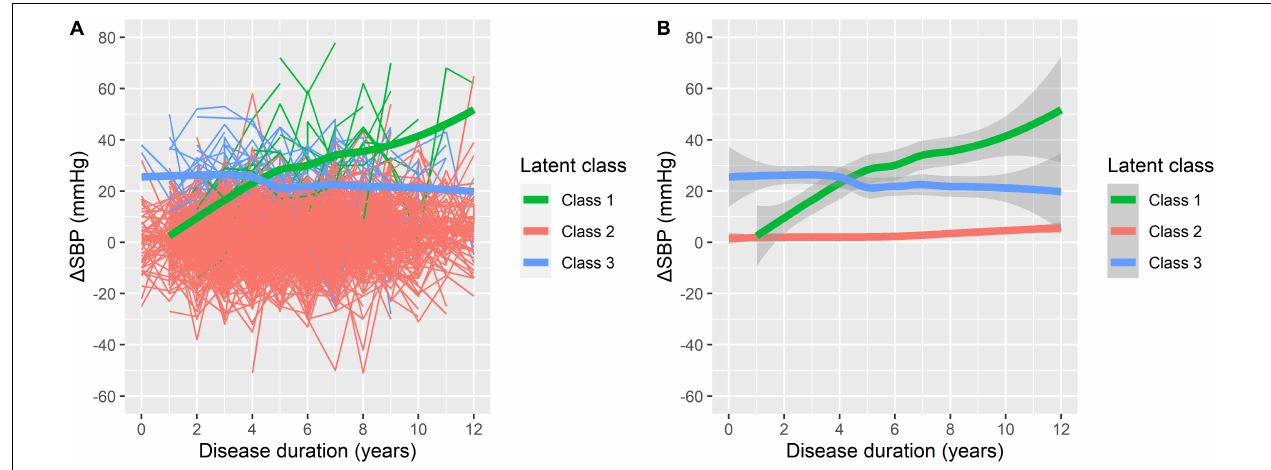
FIGURE 1 | Three latent classes of orthostatic change of systolic blood pressure ( (cid:49) SBP) trajectories. (A) The raw data for individual patient trajectories in each identified latent class. (B) A smoothing of the data represented by bold lines with shaded areas indicating the 95% confidence interval. Class 1: increasing class ( n = 18, 2.73%); Class 2: low-stable class ( n = 610, 92.42%); and Class 3: high-stable class ( n = 32, 4.85%).